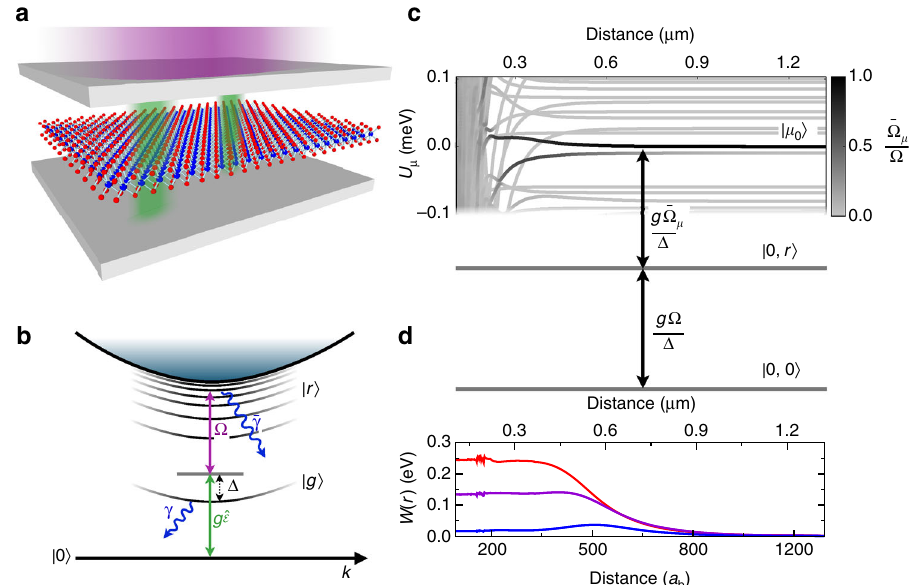
Fig. 1 Rydberg excitons in optical microcavities. a A Fabry-Pérot cavity (gray) yields strong near resonant coupling of the cavity fi eld ^ E (green) to a low- lying exciton state g j i , here it is illustrated for a two-dimensional semiconductor (TMDC monolayer). Another radiation fi eld (purple) provides coupling to excitonic Rydberg states r j i whose strong interactions generate a nonlinear response to the cavity fi eld. b The cavity fi eld generates deeply bound excitons with a coupling strength g and single-photon detuning Δ . The additional fi eld provides for two-photon resonant Rydberg state excitation with a Rabi frequency Ω . c The resulting two-photon Rabi coupling g Ω Δ from singly ( 0 ; r j i ) to doubly ( μ j i ) excited Rydberg states is strongly in fl uenced by their interactions which cause signi fi cant potential energy shifts, U μ ( r ), and distance-dependent coupling strengths Ω μ ð r Þ , depicted around the μ (at K + ) pair state. The gray coloring indicates the relative coupling from stongly- (black) to non-coupling curves (light gray). The resulting photon – photon interaction potential W ( r ) is shown in d for g /2 π = 5561 GHz 31 , Δ /2 π = 700 GHz, ground state broadening γ /2 π = 300 GHz, Rydberg state broadening γ = 2 π ¼ 0 : 3 GHz and single-photon Rabi coupling Ω /(2 π ) = 10 GHz (blue), Ω /(2 π ) = 20 GHz (purple), and Ω /(2 π ) = 30 GHz (red). The Bohr radius on the lower axis is a b = 1.11 nm